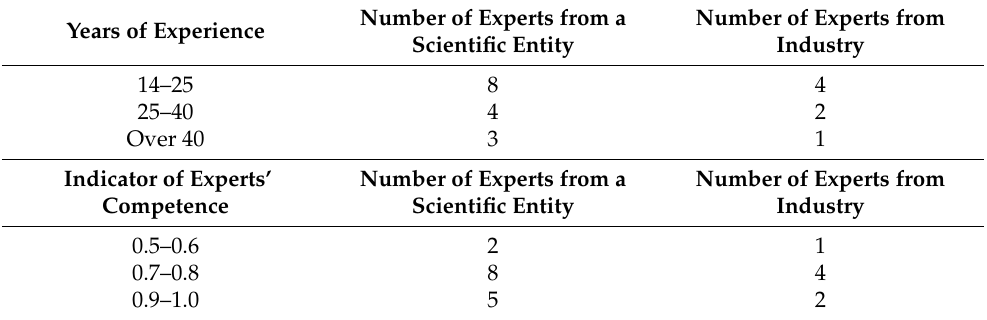
Table 1. Summary of the experts’